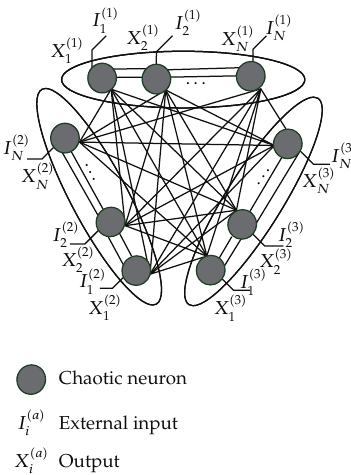
Figure 4: Structure of the memristive chaotic neural